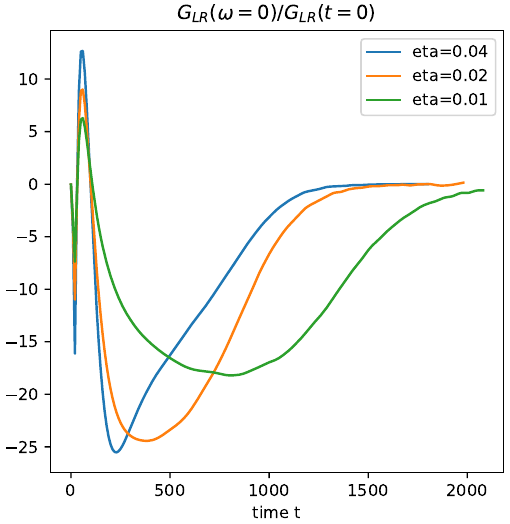
Figure 10 . The ratio (3.23) as a function of time for different values of η . For all curves µ = 0 . 05 , J = 0 . 5 , dt = 0 . 2 , β = 80 . The initial spike downwards is related to switching on the bath bath